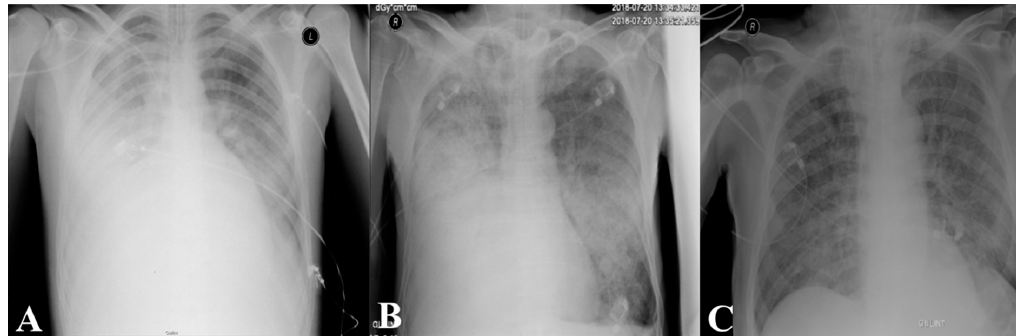
Figure 1. Final X-rays of the patients: A—1st case; B—2nd case; C—3rd case.